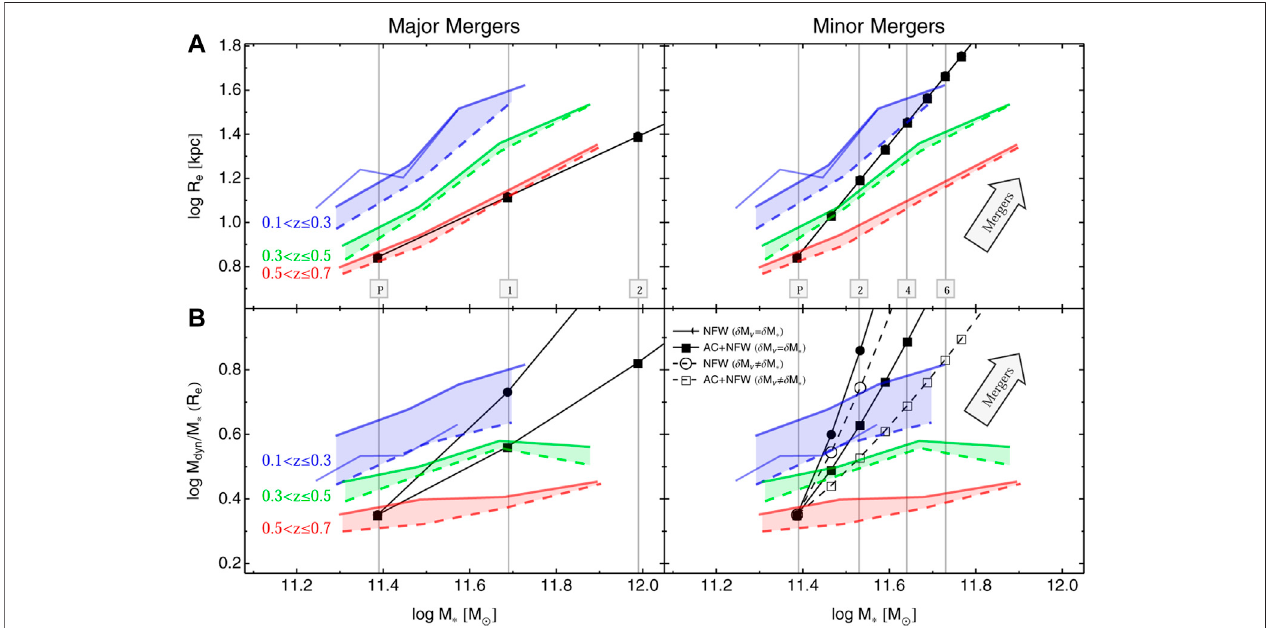
FIGURE5| Evolutionof R e – M p (A) and M dyn / M p – M p (B) .Blue,green,andredlinesareforgalaxiesinthreeredshiftbins0.1 < z ≤ 0.3,0.3 < z ≤ 0.5,and0.5 < z ≤ 0.7. Solid lines are medians for thefullsample, while dashed lines are forresults corrected forprogenitorbias.The medians for SPIDER galaxiesare plotted asthin blue lines. In the left (right) panels major (minor) toy-model merging predictions (discussed in the text) are drawn in black. We take, as example progenitor galaxy (P), the average galaxy at log M p / M ⊙ (cid:1) 11.4andevolveitaccordingtothetoy-models,thenumberofmergers isalso indicated. Inthebottompanels, dotsand fi lledsquares arefor NFW and AC + NFW pro fi les when δ M p (cid:1) δ M vir , and set the R e , M p and M dyn / M p after each single merging event. In the bottom-right panel, open circles and squaresare fortheNFWandAC+NFWpro fi leswhen δ M p ≠ δ M vir .Thedirectionofthemergereffectisindicatedwiththearrowsintherightpanels.Updatedandimprovedversionof Figure 4 of Tortora et al.